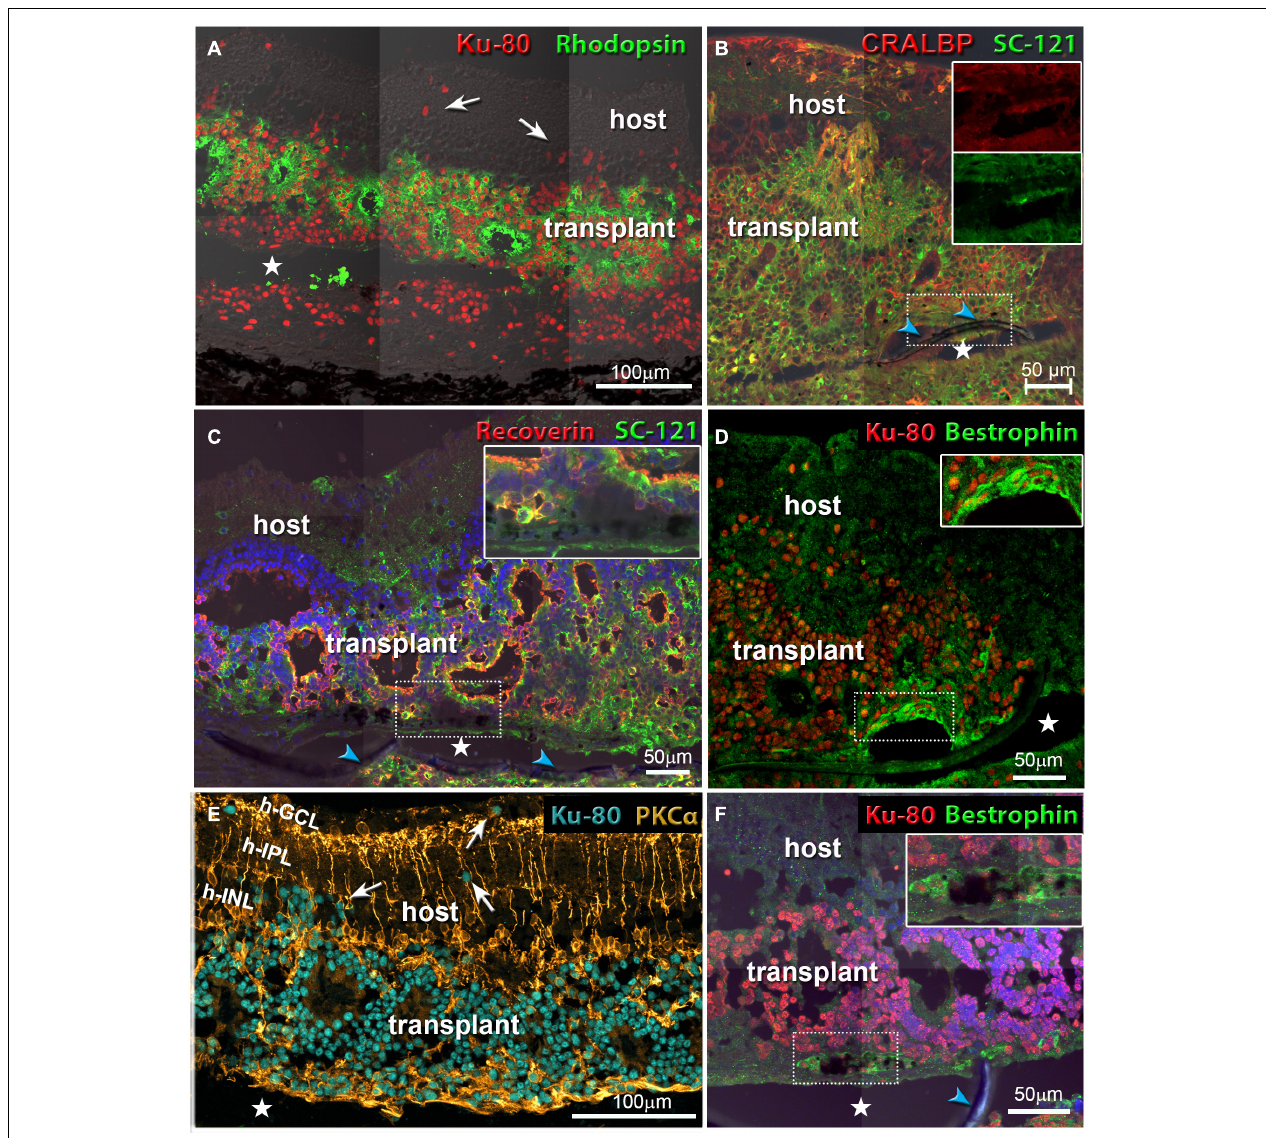
FIGURE 7 | Co-graft transplants develop different cell types and migrate into the host retina. White arrows in (A,E) point to donor cells that have migrated into the host retina. Asterisks indicate tissue space created by processing artifact (parylene implant was located there but got lost during cutting). Blue arrowheads indicate the parylene membrane. (A) Rod photoreceptors (green) have developed outer segments in rosettes. Human nuclei are stained red. The transplant has grown around the parylene implant (transplant #1 in Table 3 , 176 dps). (B) Müller glia cells and RPE stained for cellular retinaldehyde binding protein (CRALBP). Human cytoplasm is stained by SC-121 (green). The two inserts show that the RPE implant stains both for CRALBP and for SC-121 (transplant #3 in Table 3 , 197 dps). (C) Recoverin (marker for photoreceptors and cone bipolar cells, red), and SC-121 (marker for human cytoplasm, green). Insert shows an enlargement of the implant-RO interface (not-SC-recorded transplant, 127 dps). (D,F) Combination of Bestrophin (RPE marker, green) and human nuclei (red). Inserts show enlarged area of implant. (D) Same transplant as in (B) . (F) Same transplant as in (C) . (E) Rod bipolar cells (PKC α , gold), human nuclei (turquoise). Same transplant as in (A) . Scale bars = 100 µ m (A,E) ; 50 µ m (B–D,F)